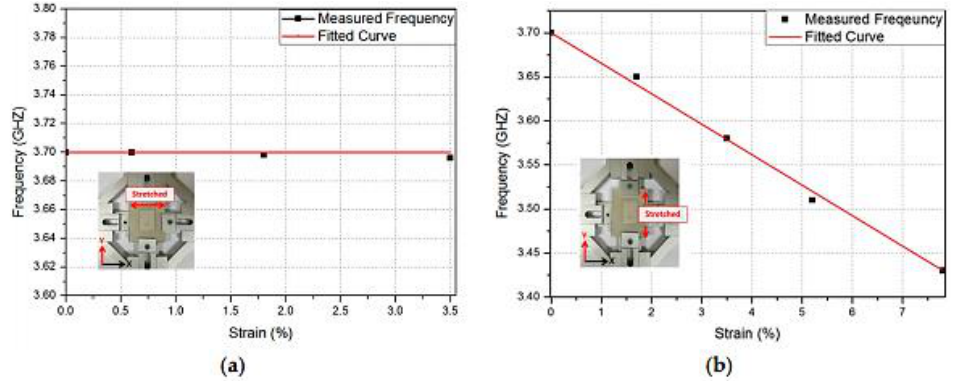
Figure 24. Relation between the resonant frequency and the strain along the: ( a ) x -direction (width); and ( b ) y -direction (length) [78]. Table 1. Comparison of RF strain sensors [78].